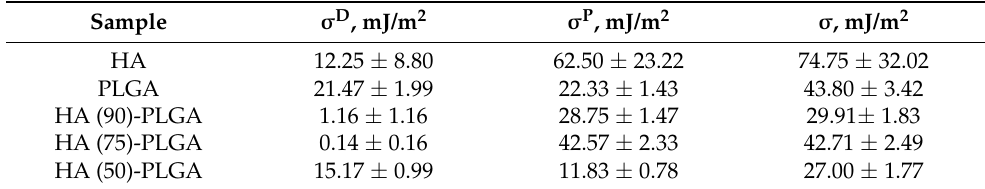
Table 8. Dispersion ( σ D ) and polar ( σ P ) components of the surface energy of materials. Sample σ D , mJ/m 2 σ P , mJ/m 2